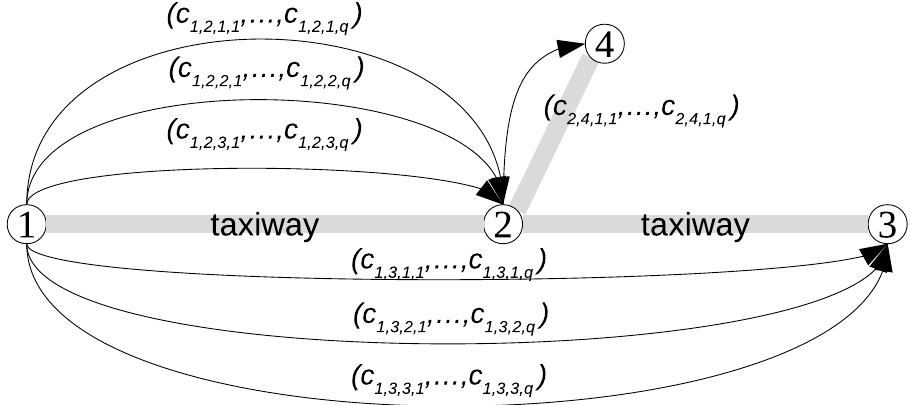
Figure 1. Each segment between nodes n , m has u speed profiles and a corresponding cost matrix C n , m ∈ R u × q with size u × q associated with it, where u and q are the number of speed profiles and objectives, respectively. The segments are the basic unit in constructing a